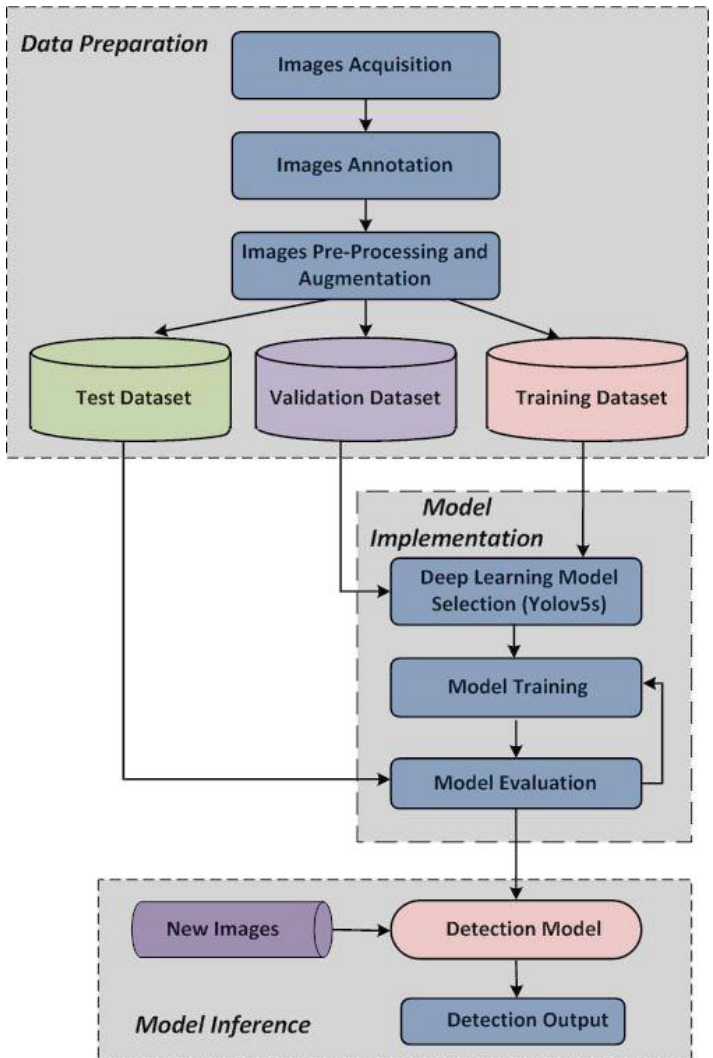
Figure 2. Block diagram of the face mask detection model